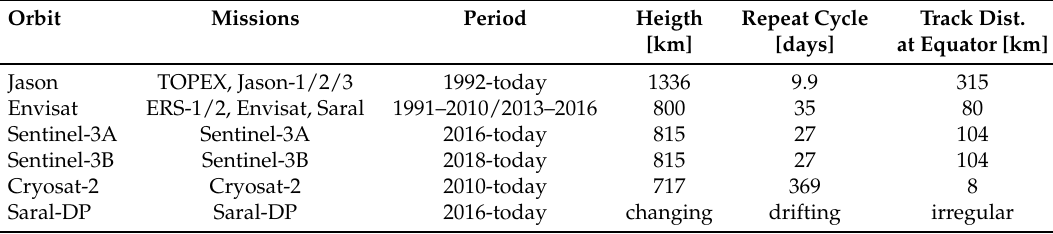
Table 1. Orbit configuration of satellite altimetry missions used in this